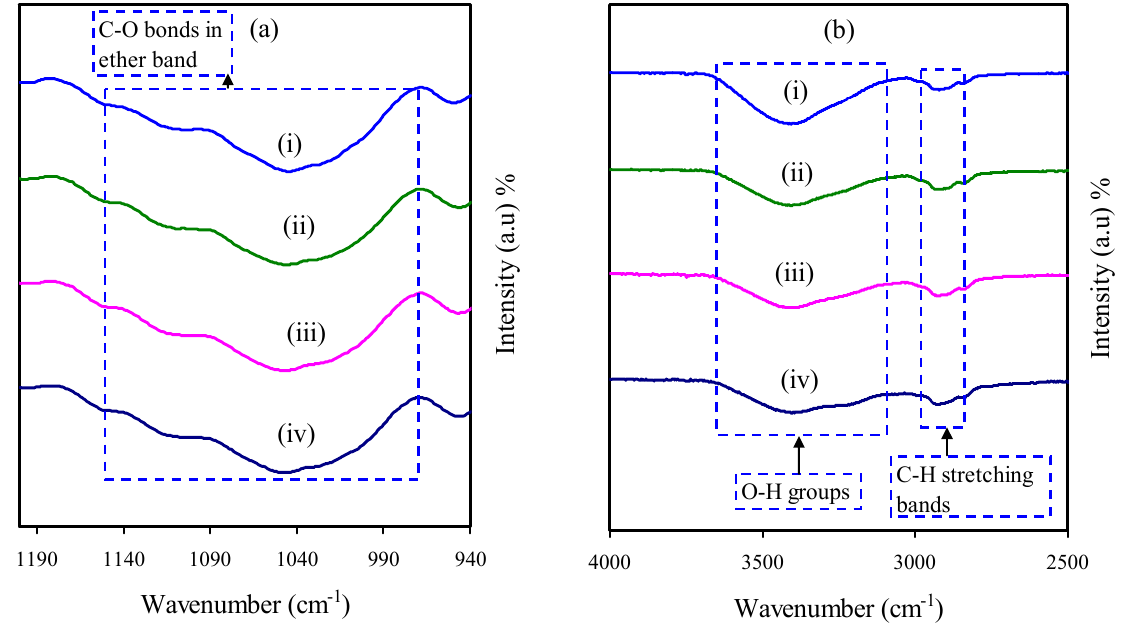
Figure 8. FTIR spectra of the MCKI samples at a wavenumber of ( a ) 940–1200 cm − 1 and ( b ) 2500–4000 cm − 1 for (i) MCKI1 (ii) MCKI2, (iii) MCKI3, and (iv) MCKI4 electrolyte samples.